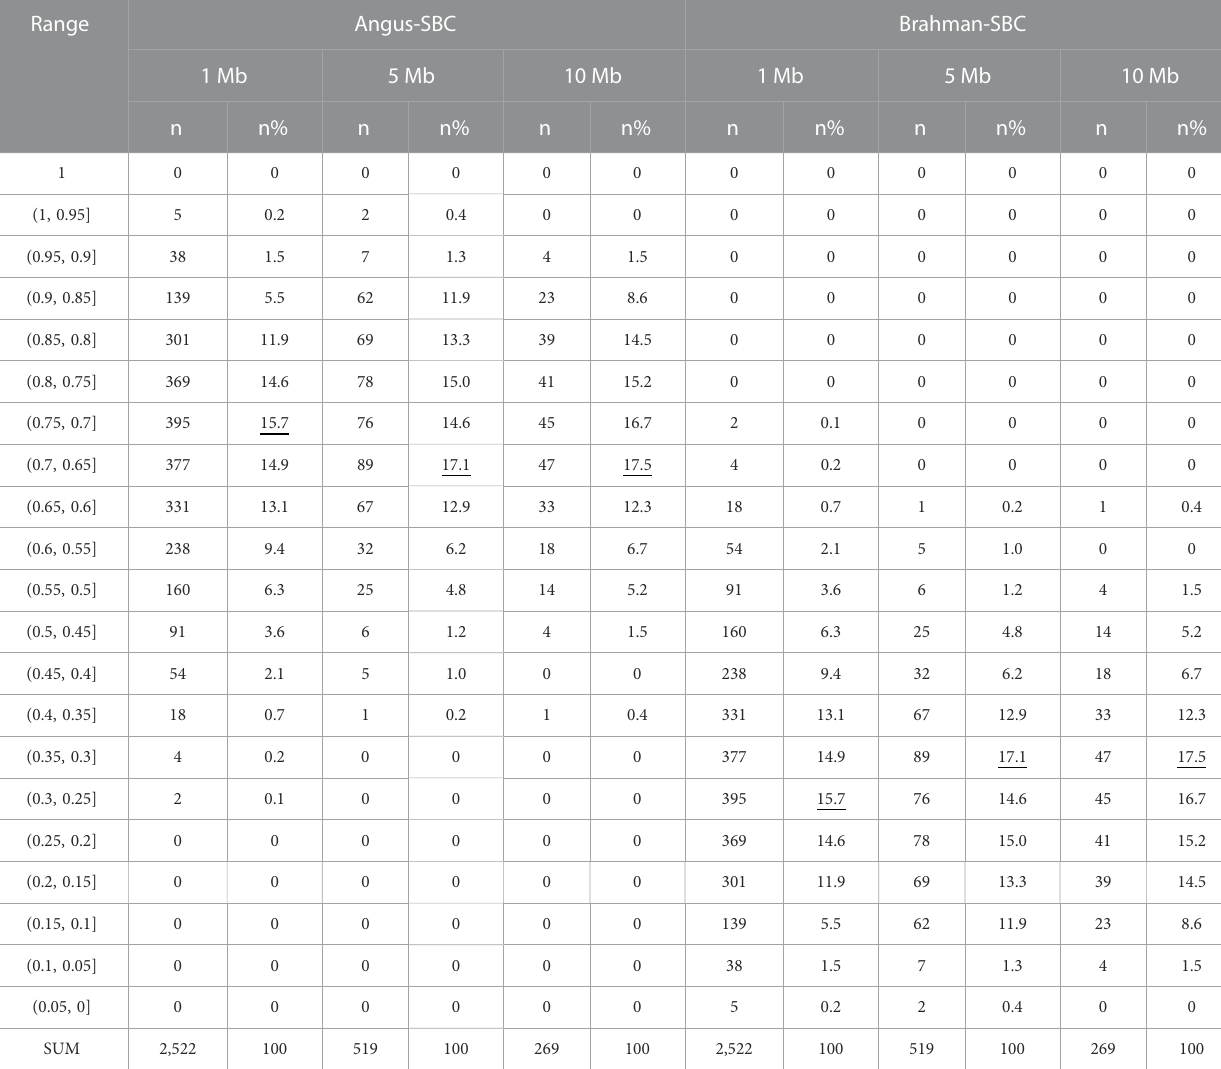
TABLE6Distributionsofsegmental-estimatedAngusandBrahmanbreedcompositions(Angus-SBC andBrahman-SBC) withthesegments de fi nedby1 MB,5 Mb, and 10 Mb intervals, respectively.